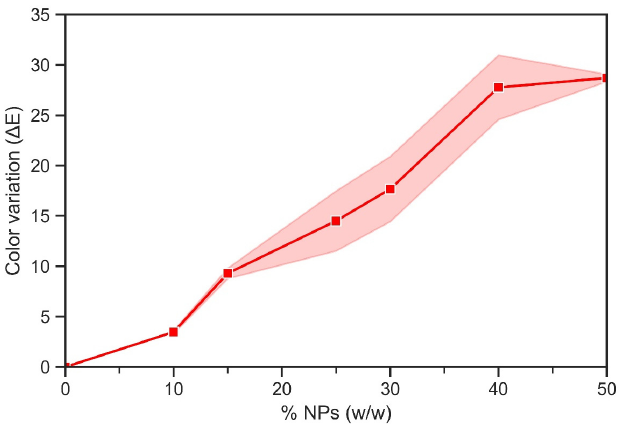
Figure 7. Color variation ( Δ E ) for different concentrations of NPs (shadowed area corresponds to the standard deviation).